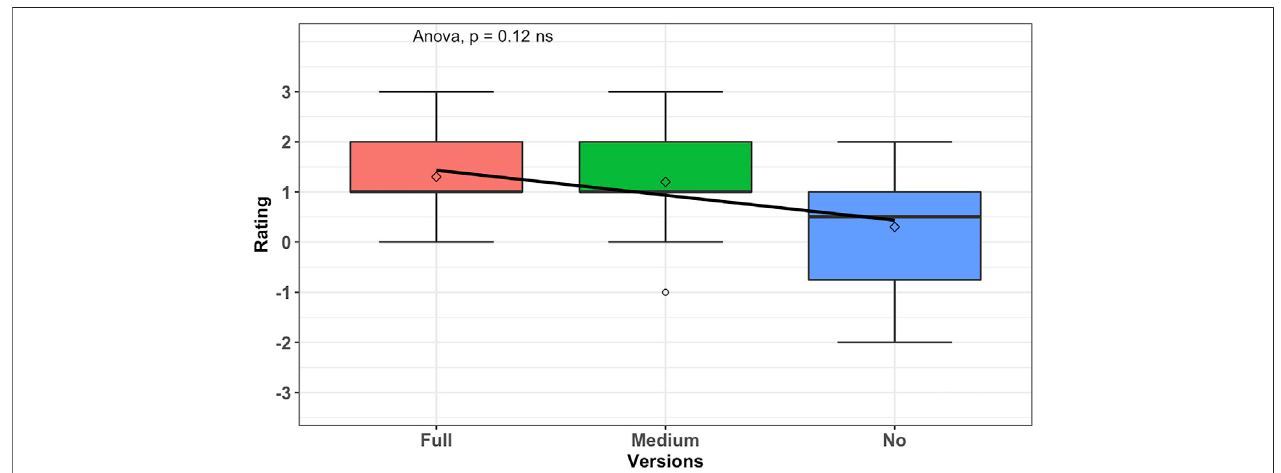
FIGURE5| Analysisresult ofnovelty from UEQ; thegraph isscaled on positive ascreative and negative as dull. Itshows thatin each version ofproactive behavior, the robot rated as creative; however, there is a visible difference on the mean from full to no proactive